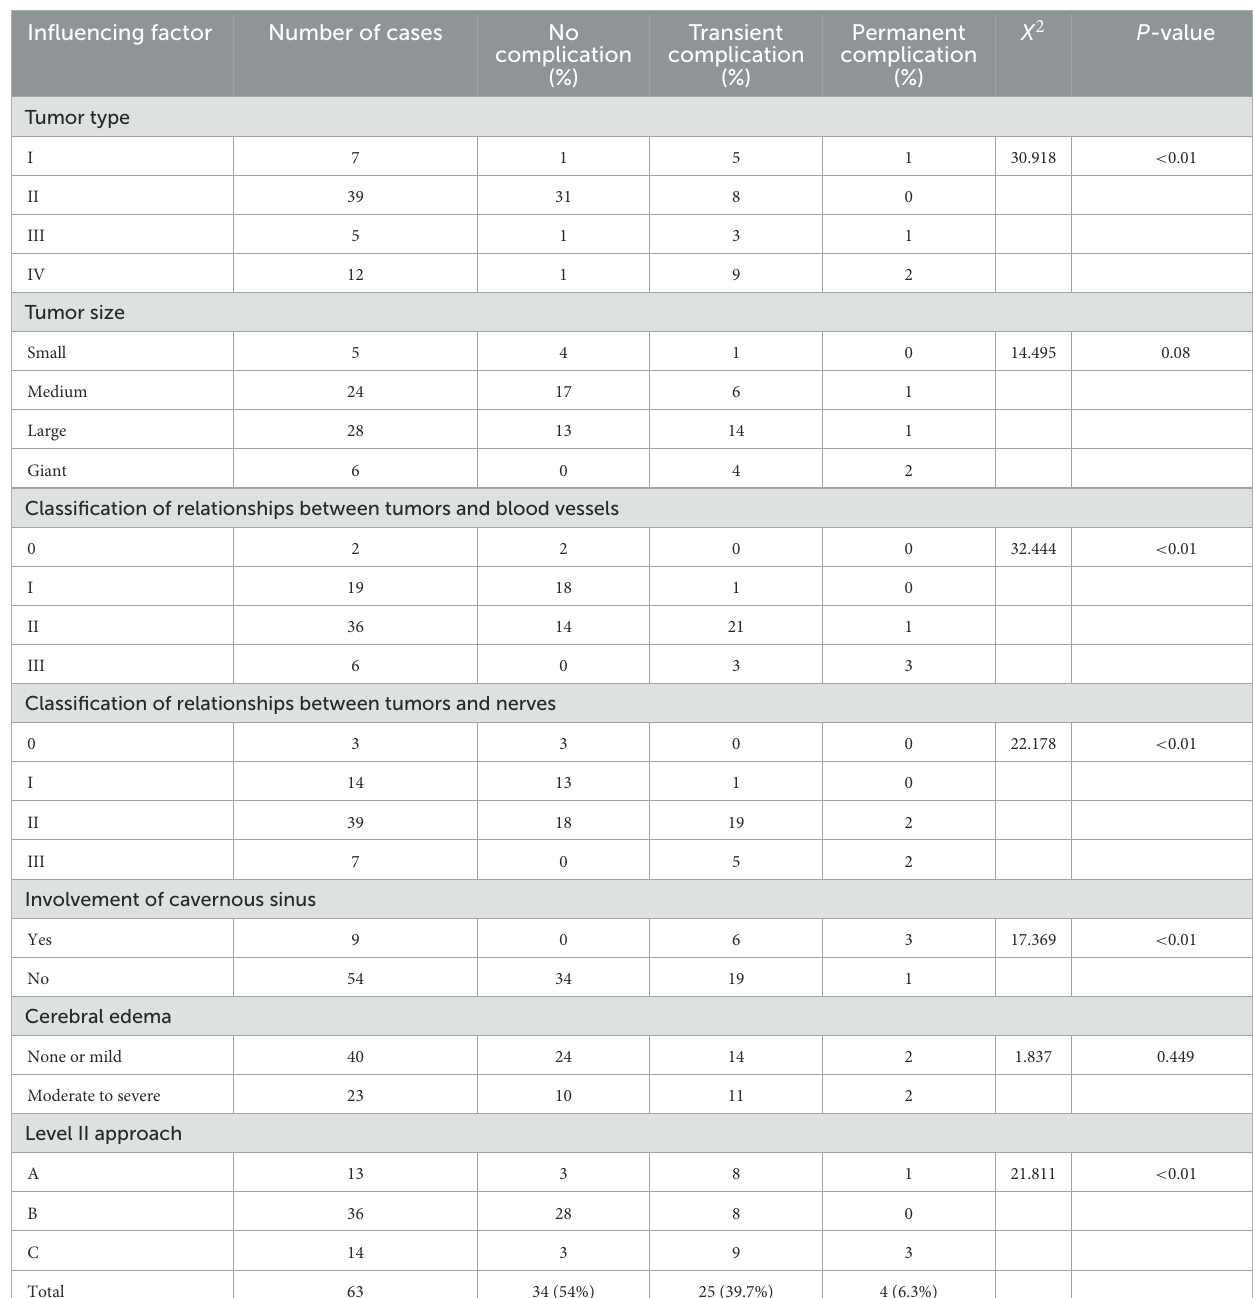
TABLE 8 Analysis of factors influencing postoperative